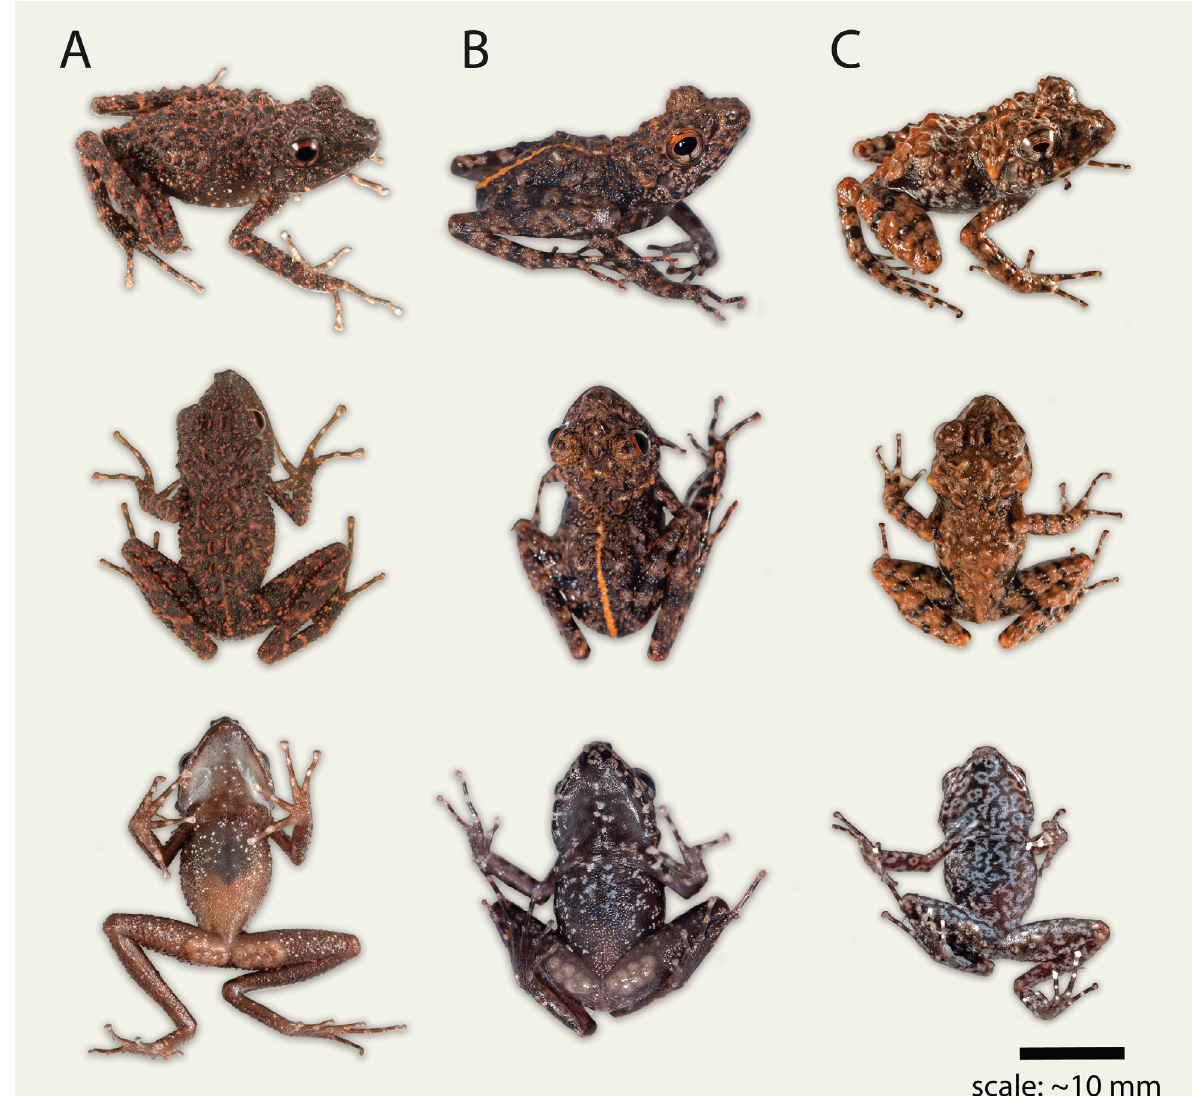
Figure 5. Ex-situ dorsal-lateral, dorsal and ventral photographs of A. Male Gephyromantis marokoroko sp. nov. (holotype, KU 343230); B. Gephyromantis striatus (Marojejy, ZCMV 15140; photographs by Mark D. Scherz); and C. Gephyromantis ventrimac- ulatus (Ranomanfana, KU